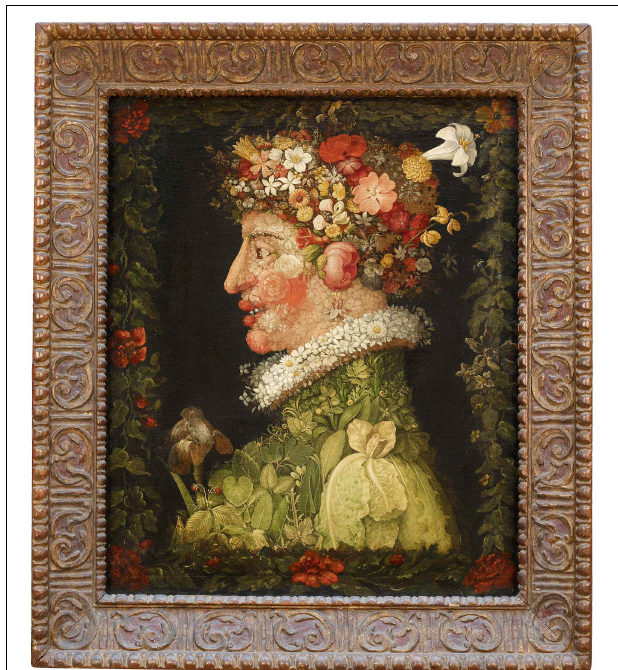
FIGURE 7 | Giuseppe Arcimboldo, The Spring, 1563, Oil on oakwood, 66 × 50 cm, Musée du Louvre, Paris. Photo © Musée du Louvre, Dist. RMN-Grand Palais/Angèle